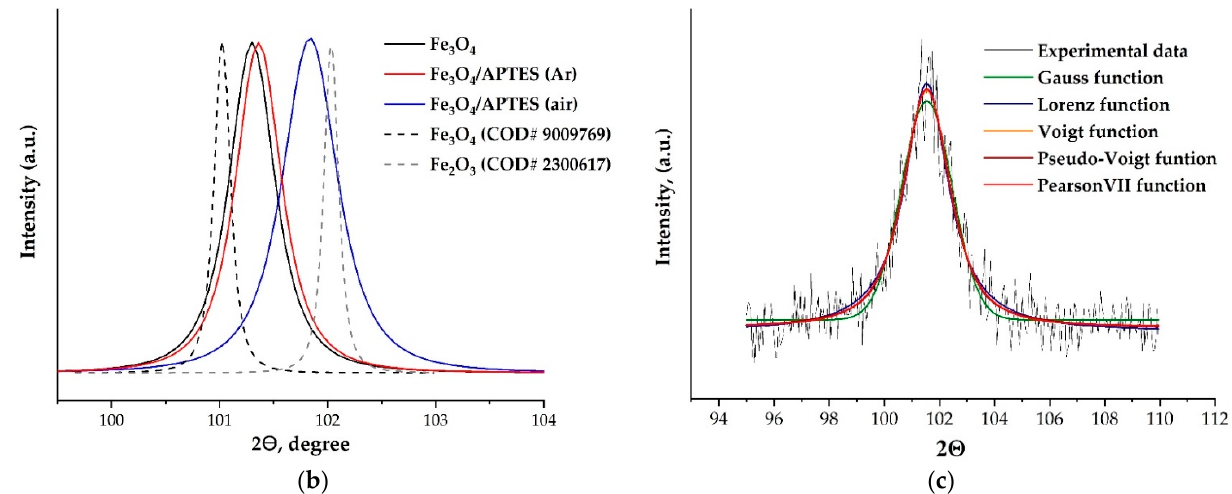
Figure 1. ( a ) Powder X-ray diffraction (XRD) of products with the magnetite and maghemite patterns from the Crystallography Open Database (COD) ( b ) Peak 440 of products and magnetite and maghemite COD patterns ( c ) Different models fitting by peak 440 of Fe 3 O 4 /APTES (air). Table 1. Microstructure of MNPs.